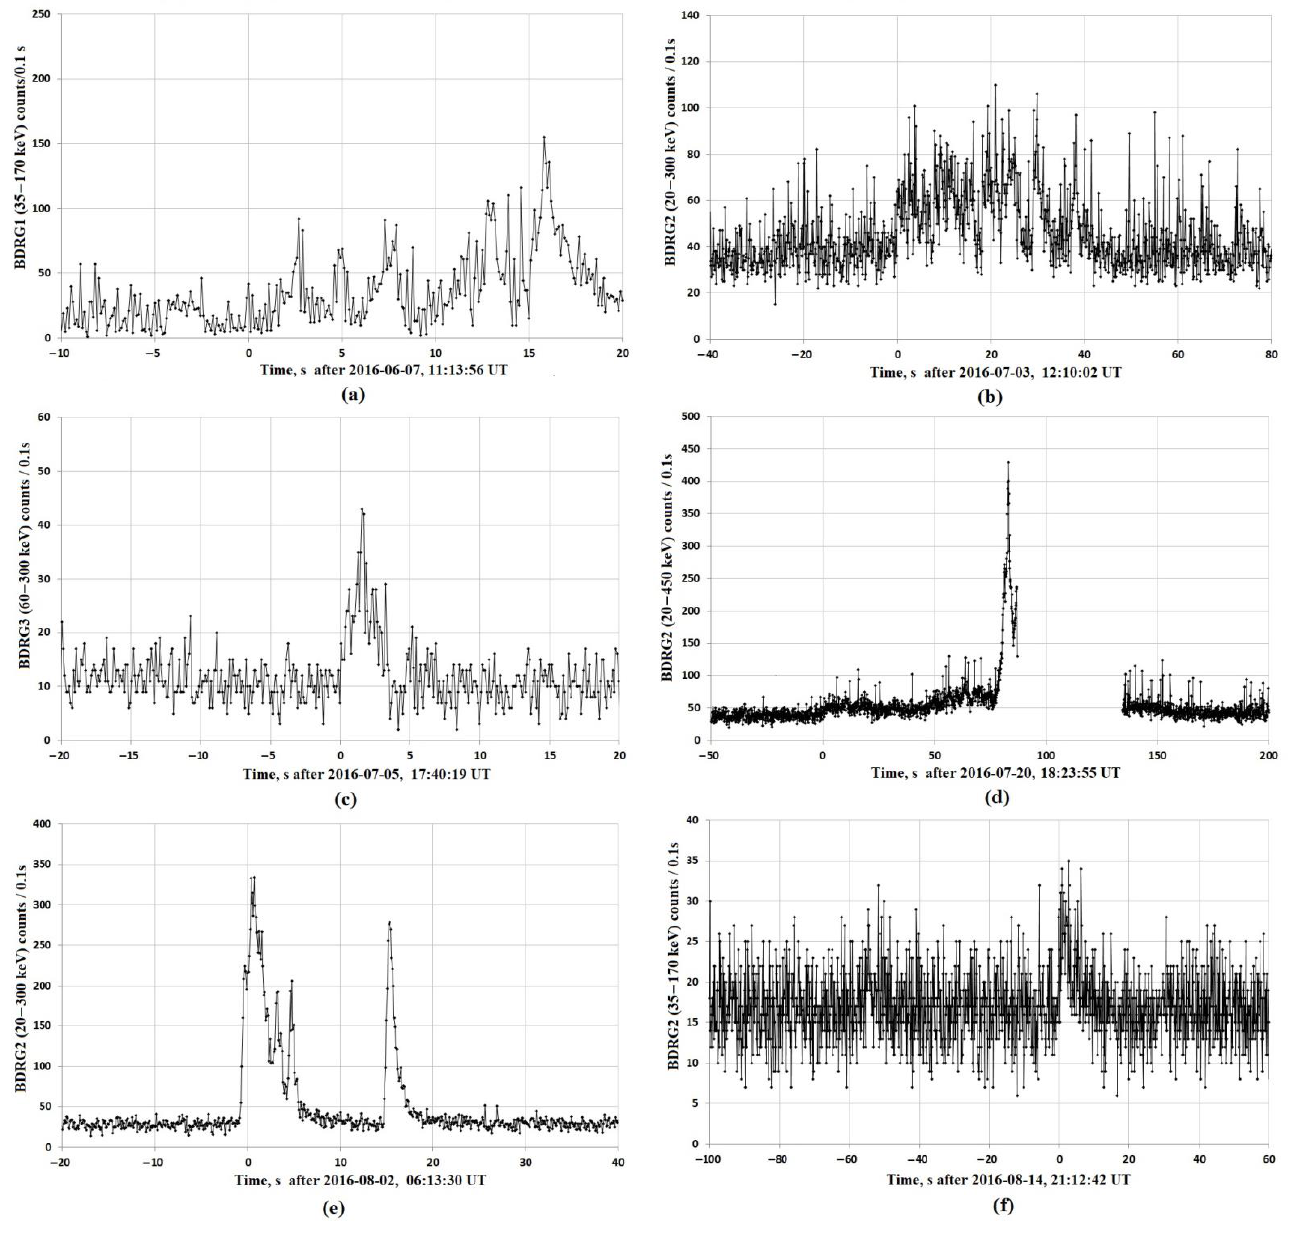
Figure 4. Light curves of BDRG/Lomonosov GRBs. ( a ) 2016 − 06 − 07, 11:13:56 UT; ( b ) 2016 − 07 − 03, 12:10:02 UT; ( c ) 2016 − 07 − 07, 17:40:19 UT; ( d ) 2016 − 07 − 20, 18:23:55 UT; ( e ) 2016 − 08 − 02, 06:13:30 UT; ( f ) 2016 − 08 − 14, 21:12:42 UT.